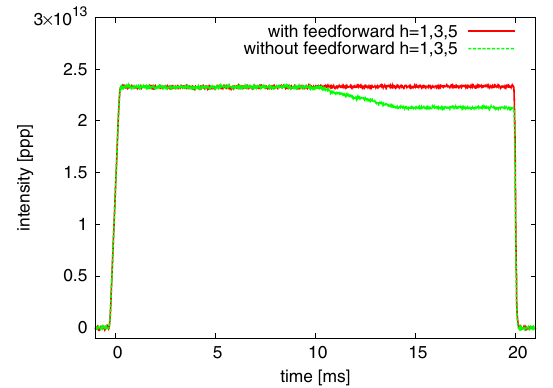
FIG. 5. Beam intensities from injection to extraction with and without feedforward for the odd